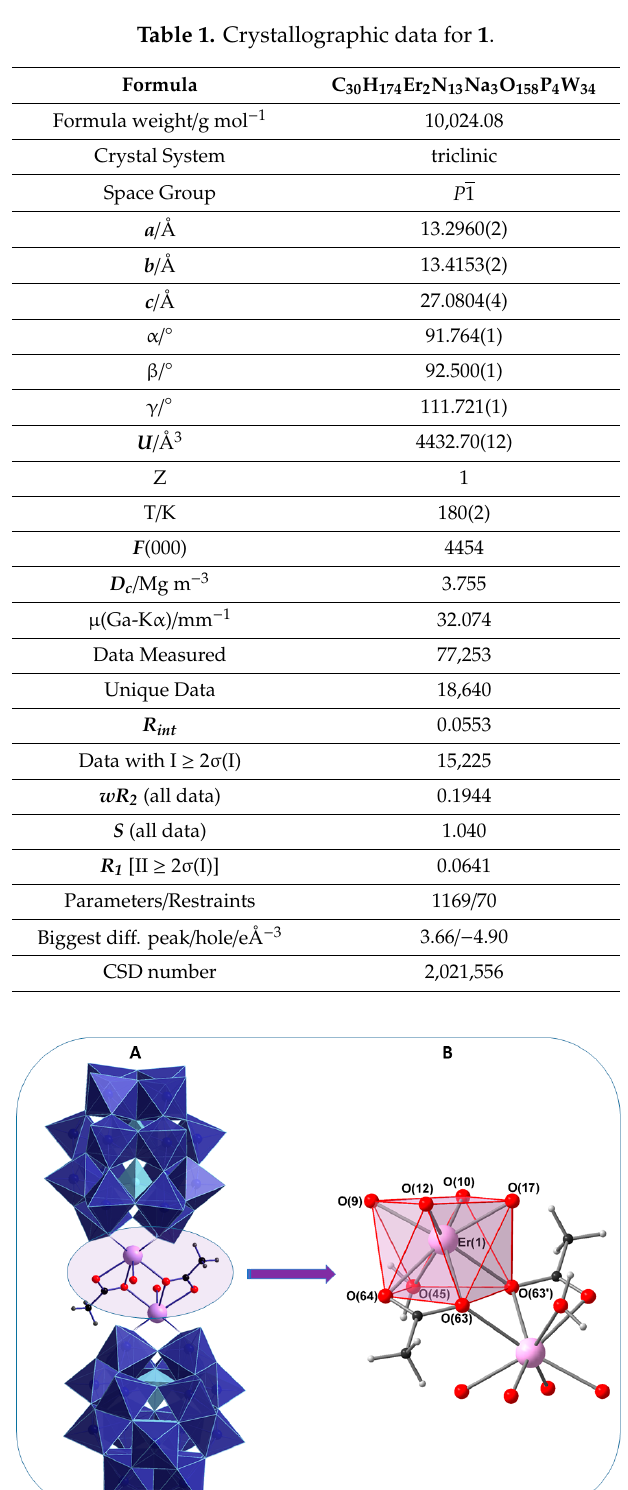
Table 1. Crystallographic data for 1 .